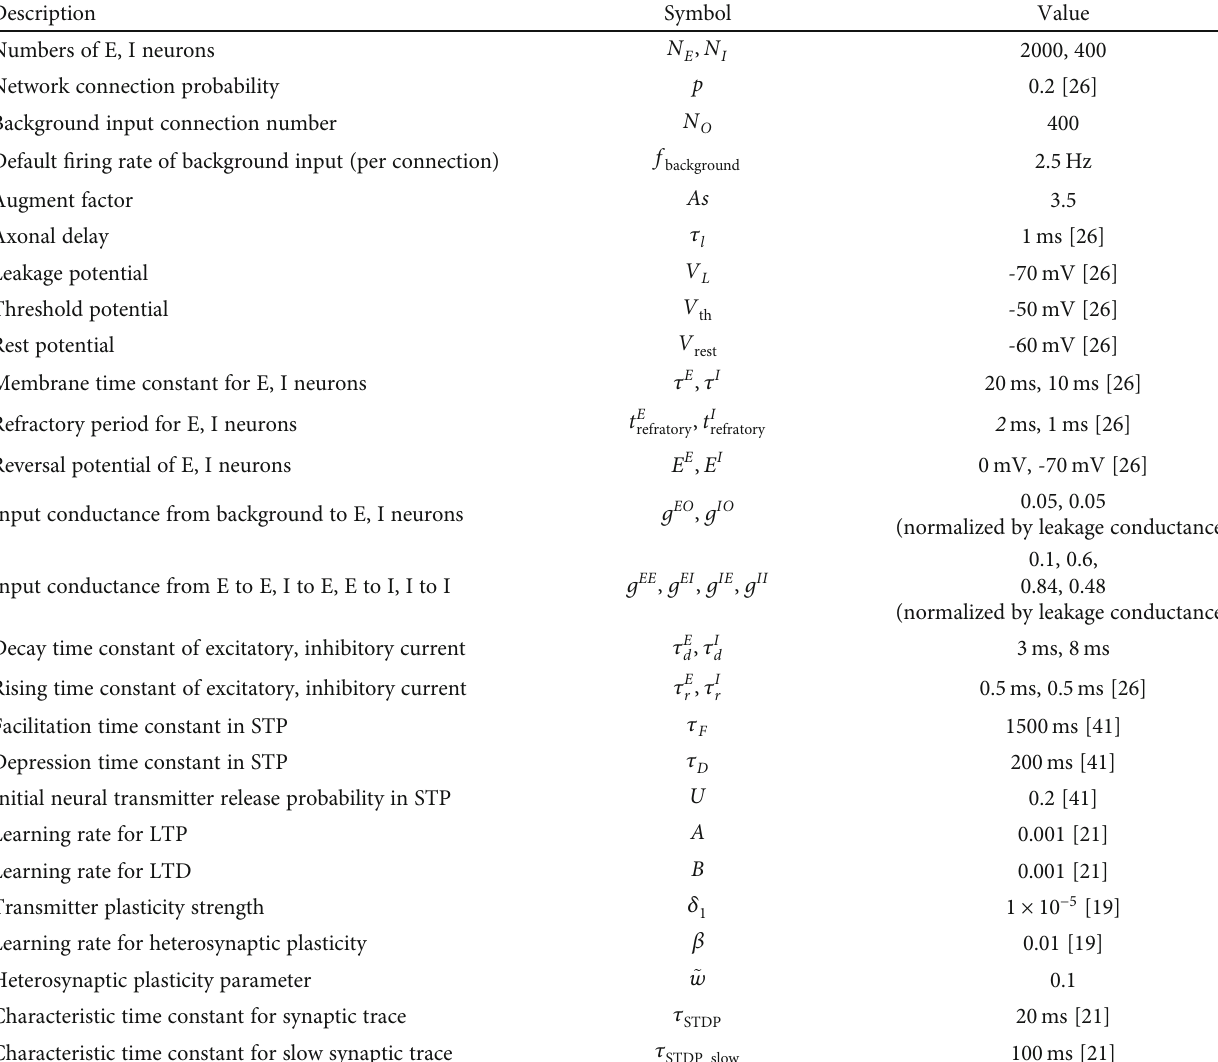
Table 1: Parameter used in neural